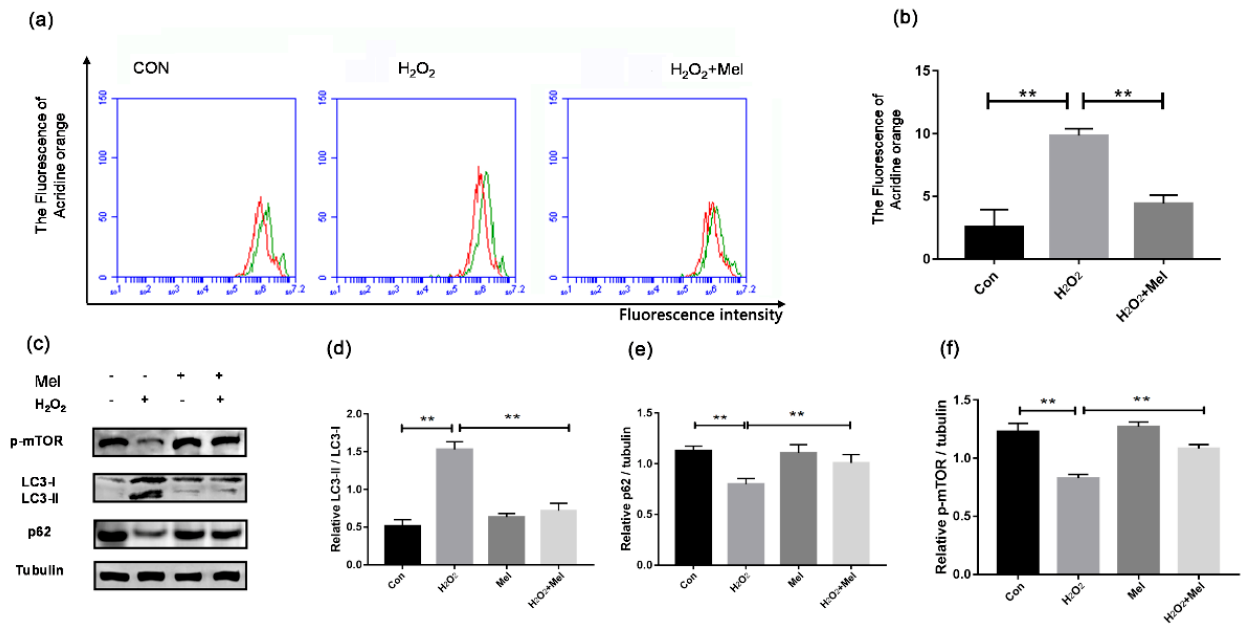
Figure 1. MEL suppressed the oxidative stress-induced autophagy of GCs. Primary cultured GCs were pre-treated with H 2 O 2 (200 μ M) for 1 h, and then treated with MEL (10 μ mol/L) for another 2 h. The acidic autophagic vacuoles were detected using acridine orange staining and detected by FCM, and the LC3 protein was detected by Western blotting with anti-LC3. The +Y axis is 100 times the number of cells, and the + X axis is the intensity of cell fluorescence. ( a , b ) The fluorescence degree of acridine orange. ( c – f ) Immunoblot assay for the expression of LC3, p62 and p-mTOR in GCs. α - tubulin served as the control for loading. Experiments were repeated in triplicate. Data represent mean ± S.E; n = 3. ** Represents p < 0.01 compared to control group.